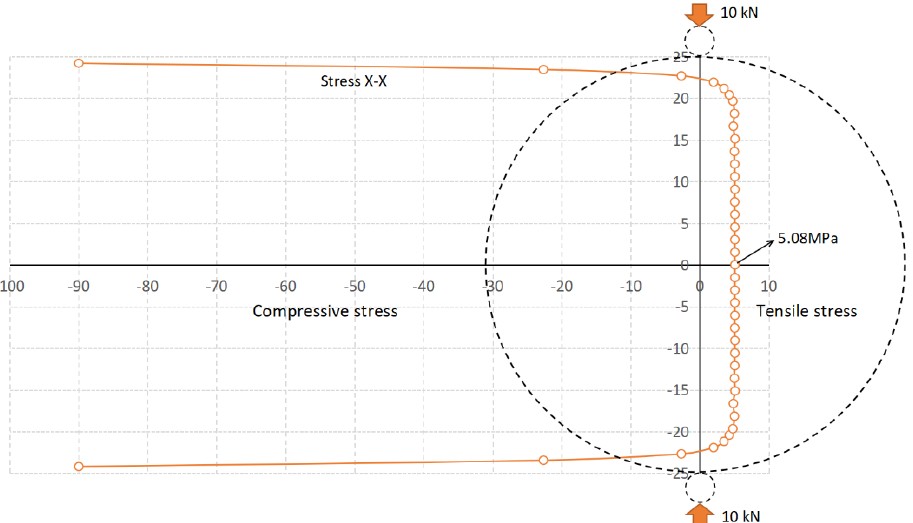
Figure 11. Location of stress monitoring line in Brazilian disc.